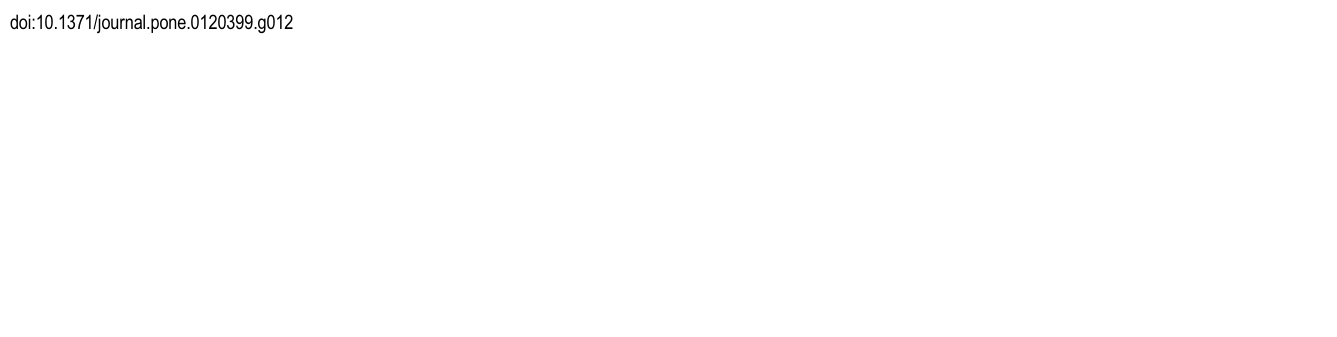
Fig 12. Comparisons of Li ’ s model, LSACM and our model for MR brain image. Column 1 is the original image with red and blue initial contours. Column 2 to 4 is the final segmentation results, the corrected images and the estimated bias field images, respectively. Row 1 to 3 is the results of Li ’ s model, LSACM and our model,